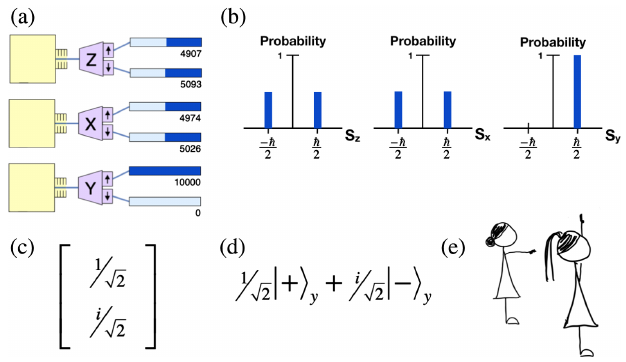
FIG. 2. Various representations of a spin- 1 = 2 state ( jþi y ): (a) schematic of the results of Stern-Gerlach experiment, (b) histo- grams of probabilities of values of spin, (c) matrix notation, (d) Dirac (bra-ket) notation, (d) arms notation. Note that jþi y denotes the state corresponding to spin-up in the y